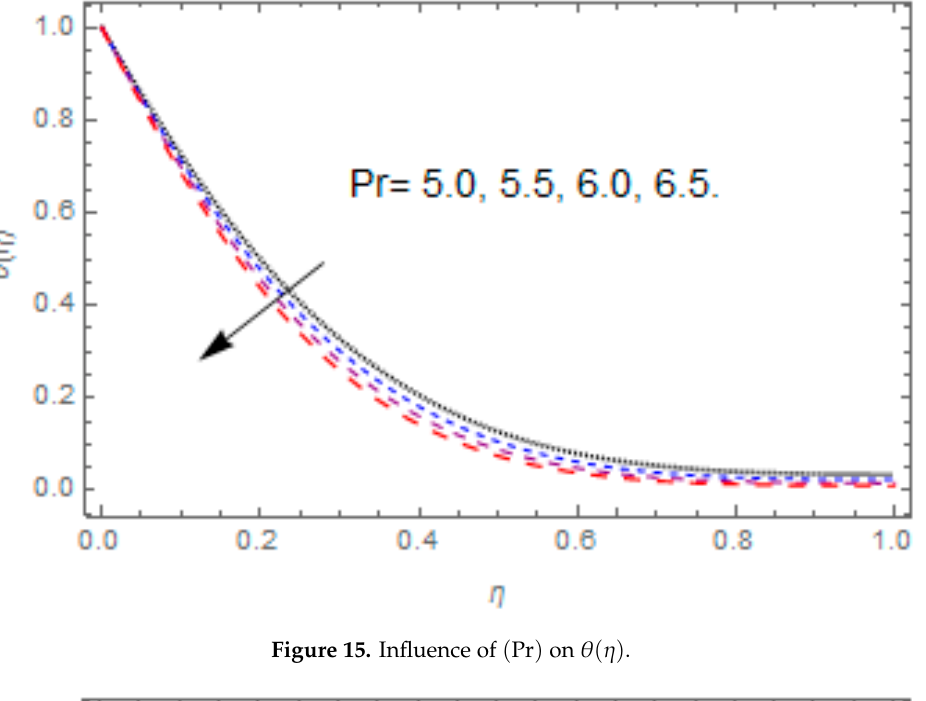
Figure 15. Influence of (Pr) on ( )